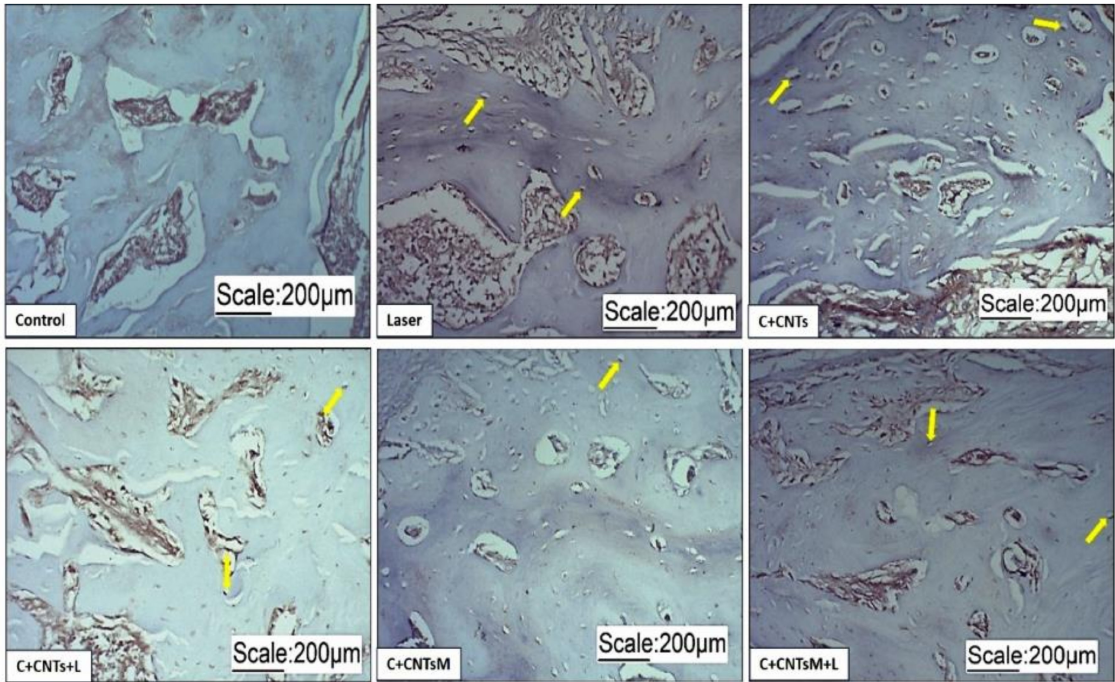
Figure 10. Optical microscope images of osteopontin immunostaining of the groups studied. Osteo- cytes were identified by the expression of osteopontin (yellow